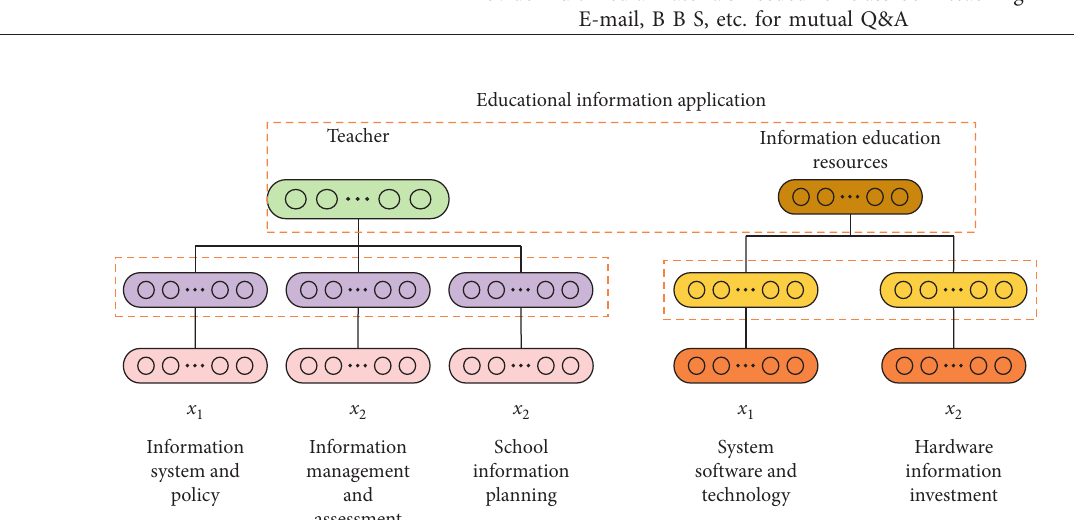
Figure 3: Interpretation structure model of influencing factors of school informatization